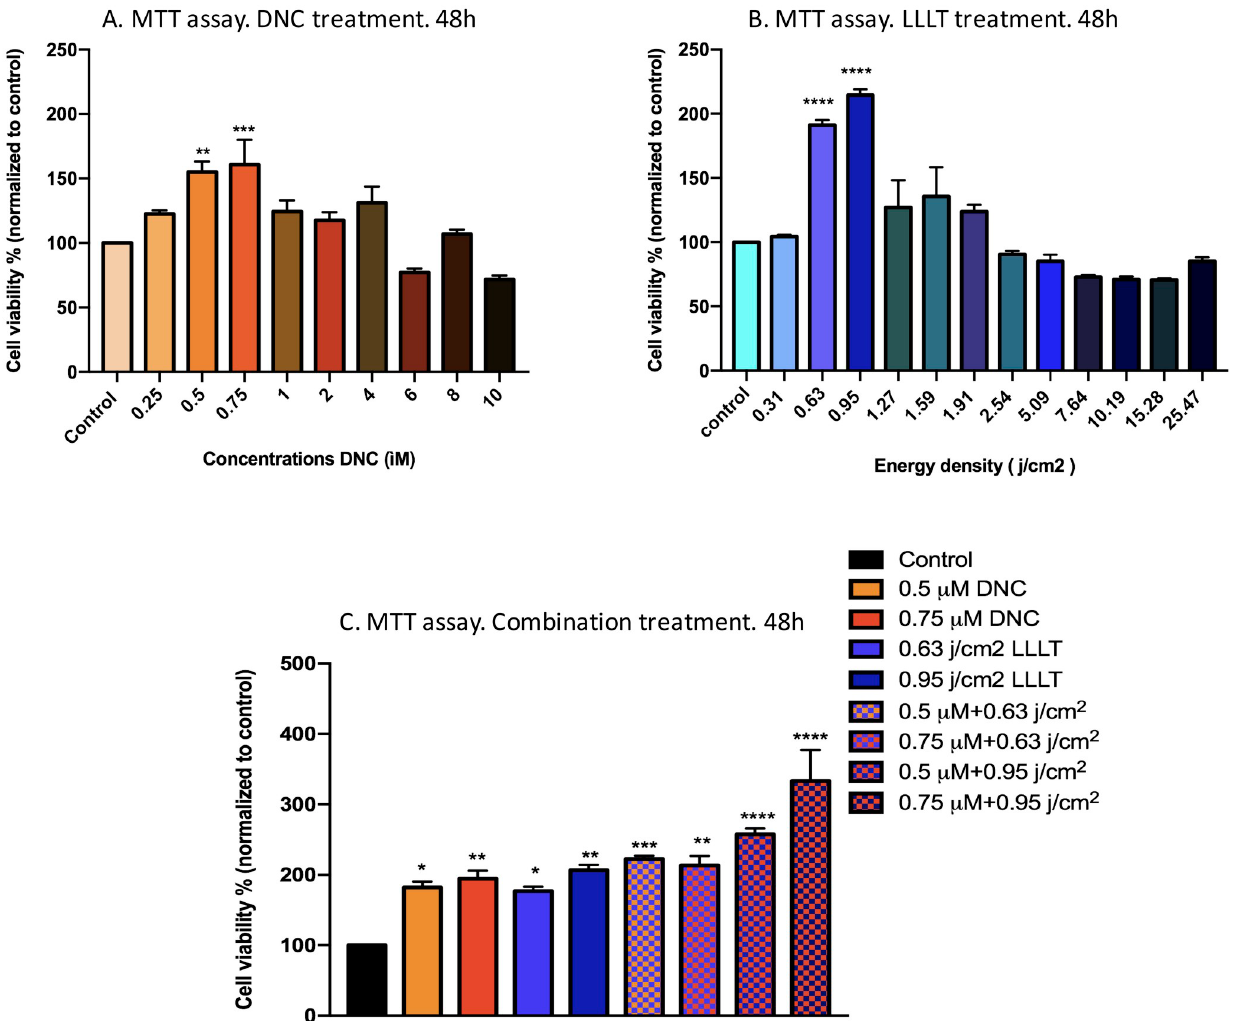
Fig 1. Comparative analysis of survival and growth rate of MEFs under the treatment of increasing doses of (A) Dendrosomal Nano Curcumin (0.25– 10 μ M) and (B) low-level laser therapy 450 nm (0.31–25.47 j/cm 2 ) and (C) Combination treatment with optimal doses of DNC and LLLT, after 48h investigated by MTT assay. � Indicates that there is a significant difference between the experimental and control groups. Data are reported as mean ± SEM; n = 3 ( � : P < 0.05, �� : P < 0.01, ��� : P < 0.001, ���� : P <